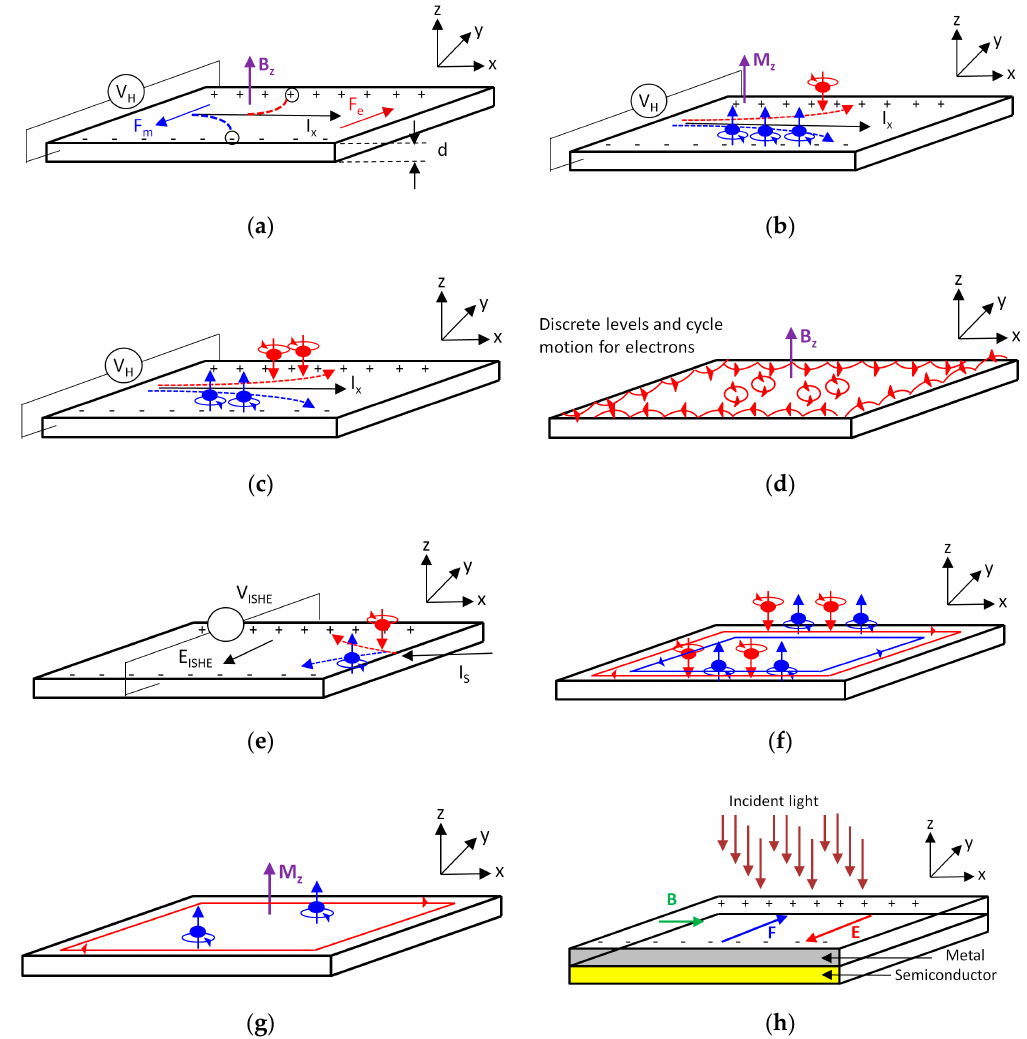
Figure 3. The main known Hall Effects and the year of their publication. ( a ) Original Hall Effect (OHE)